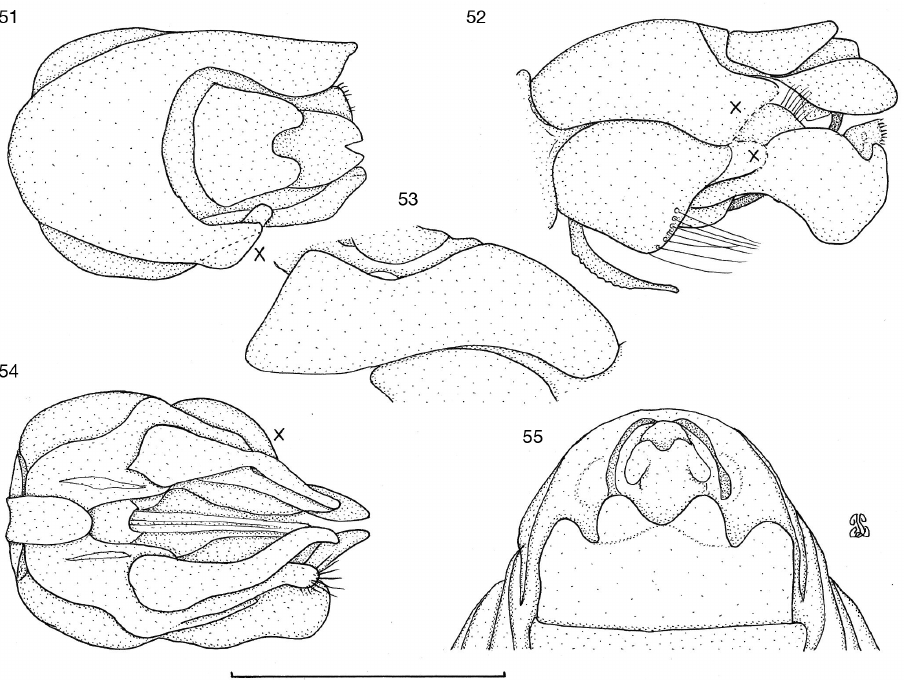
Figures 51–55. Laphyctis orichalcea terminalia: 51 male (Brandberg) dorsal 52 same, lateral (left side) 53 same, lateral (right side) 54 same ventral 55 female (Otjiu) ventral. x = damaged. Scale = 1 mm, seta- tion